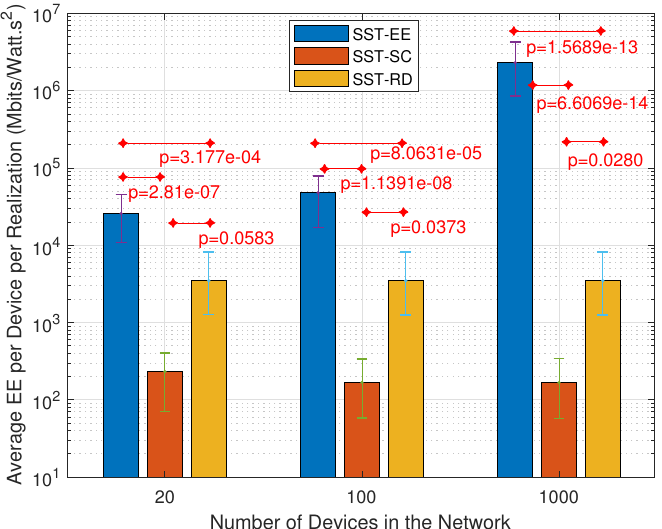
Figure 11. Variation in the average energy efficiency per device per realization considering the